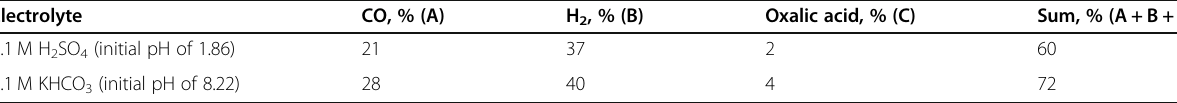
Table 2 Faradaic efficiencies of various products obtained after 3 h of CO 2 RR Electrolyte CO, %